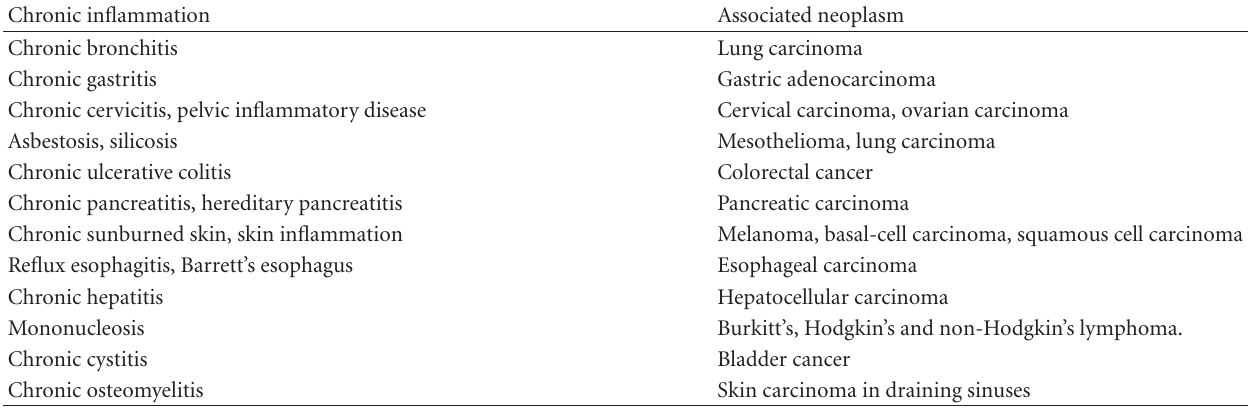
Table 1: Chronic inflammatory diseases and associated cancers.